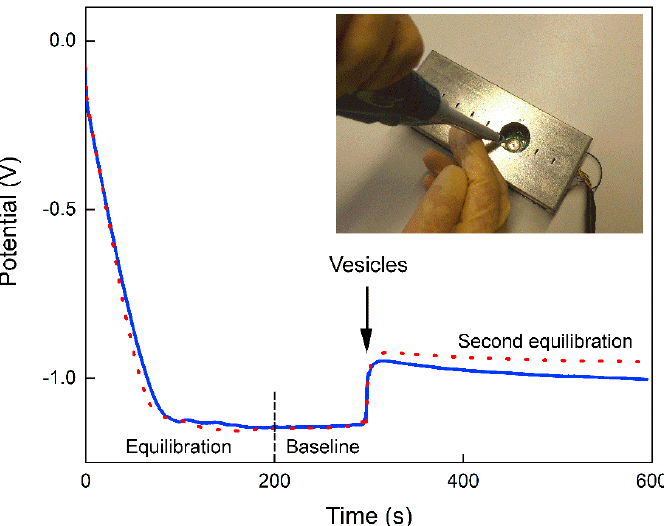
Figure 3. Potential (V) versus time (s) curves recorded using the BNCD microelectrode in the presence of deionized water. A volume of 10 μ L of liposomes (0.6 mg/mL of total lipid) (dot line) or proteoliposomes (0.6 mg/mL of total lipid containing 14 μ g/mL of AnxA5) (continuous line) were added to the microelectrode compartment after 300 s. After initial equilibration a nearly stable baseline was reached. Since this equilibration is not relevant for the signal analysis, the following figures focus on the time range from 200 to 600 s. The potential steps observed after dispensing the vesicles are due, in this case, to the Tris-HCl buffered vesicle solutions, since no other ions are present. Such steps drop down by a few tens of millivolts over the next 300 s, indicating a second equilibration transient. The inset shows the device inserted in the readout electronics inside the shield box and the dispensing of the vesicle sample by manual